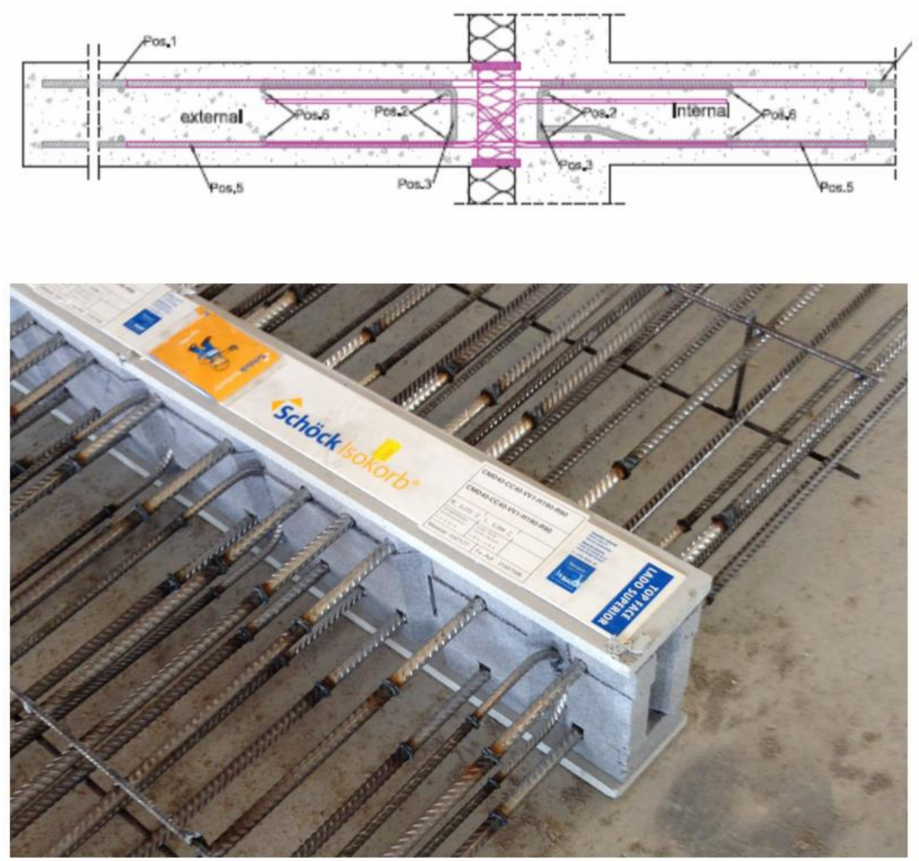
Figure 1. Cross section and detail of the installed balcony thermal break.